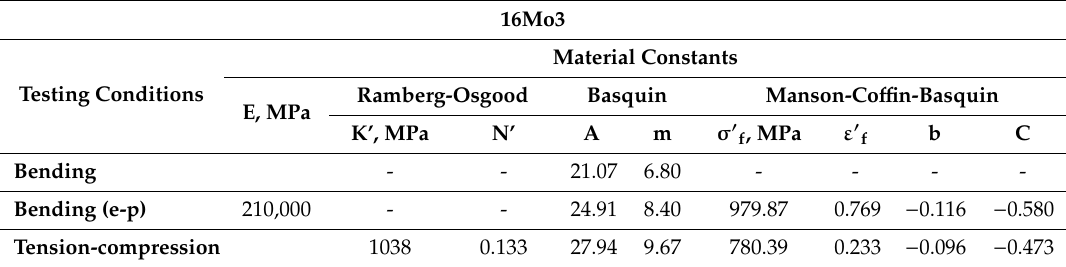
Table 1. Comparison of material constants for the 16Mo3 steel in fatigue tests under tension-compression and oscillatory bending conditions.